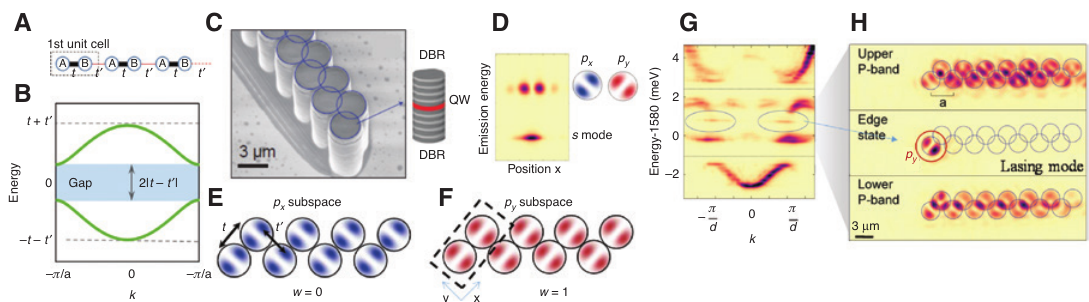
Figure 2: 1D topological microcavity polariton laser. (A) Scheme of the SSH lattice, defined by two sites per unit cell (A and B) and alternating hopping t and t ′ . (B) Spectrum of the eigenstates of the SSH Hamiltonian when t ≠ t ′ . (C) Realization of the SSH Hamiltonian for p modes in a zigzag chain of coupled micropillars. (D) Emitted photoluminescence from a single micropillar, showing gapped s and p modes. (E, F) Schematic representation of the p the zigzag chain. Each subspace implements an SSH chain with different winding. (G) Photoluminescence intensity from the zigzag